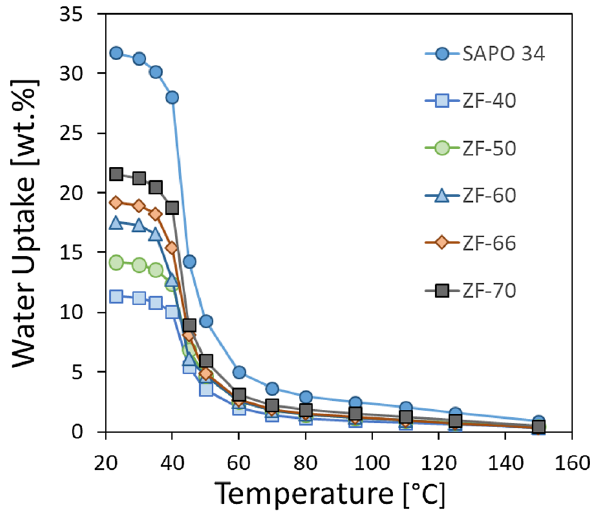
Fig. 7 Water adsorption isobars at 11 mbar for filled zeolite foams and pure zeolite